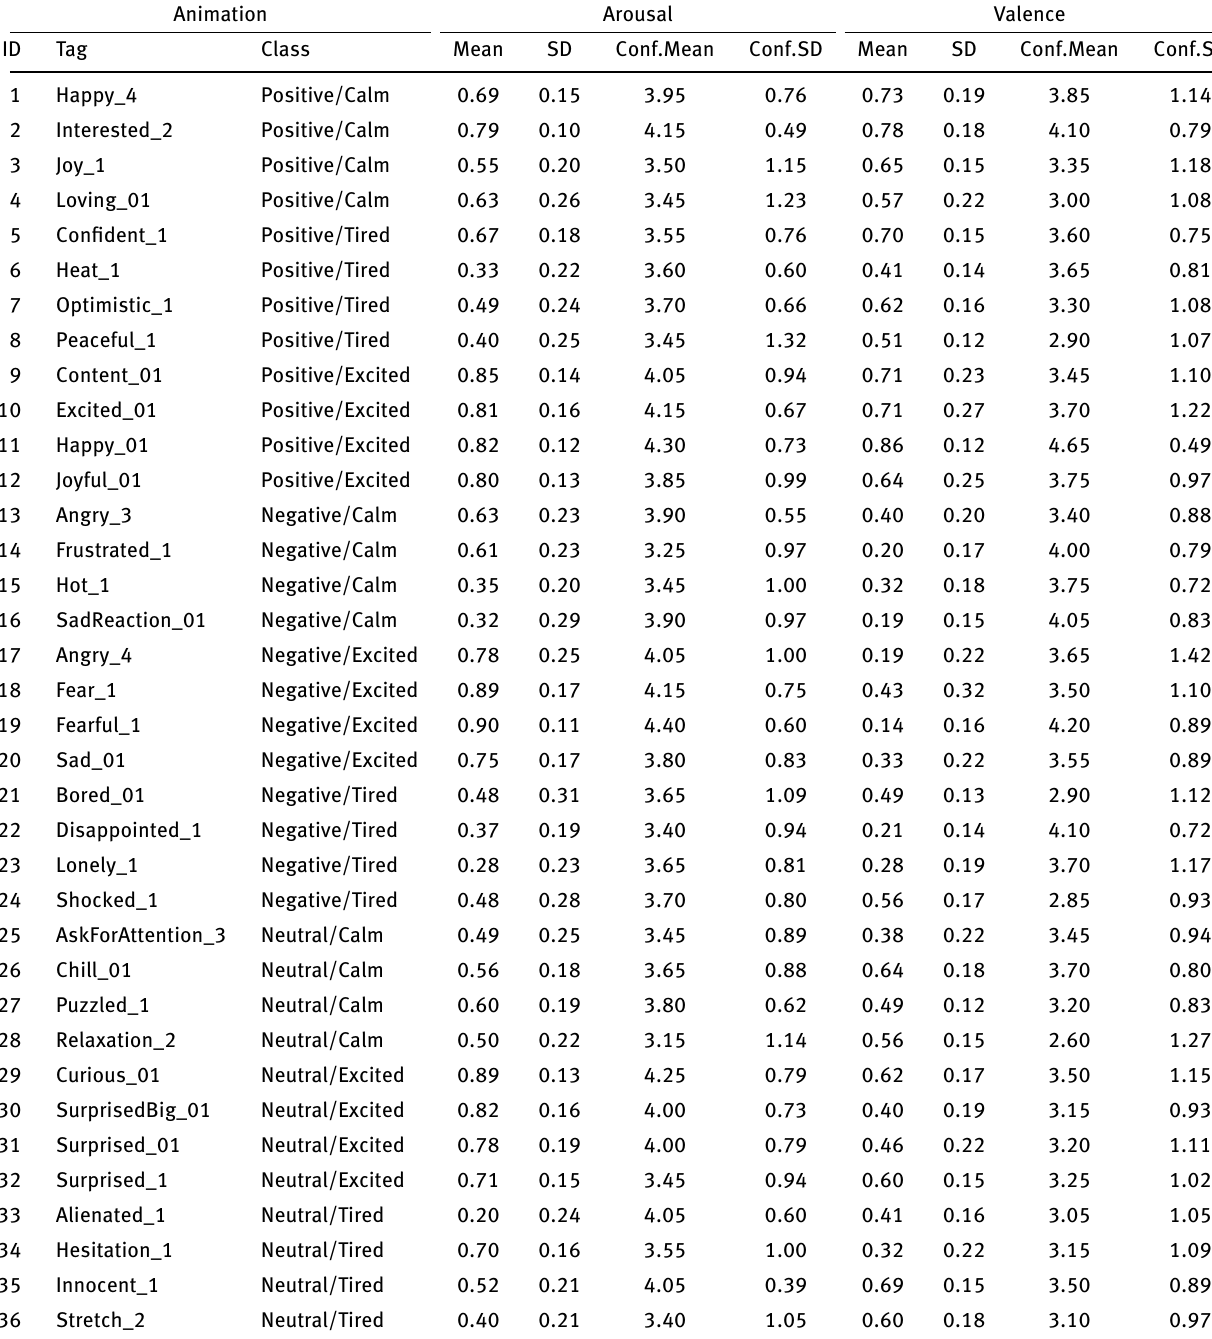
Table 6: The final affect labels (means across 20 raters for valence and arousal) with the averaged confidence in judgment, as well as the original categorical tags of the animations and the pre-assigned classes of valence/arousal levels combinations. The ratings range from 0 to 1, with 100 points